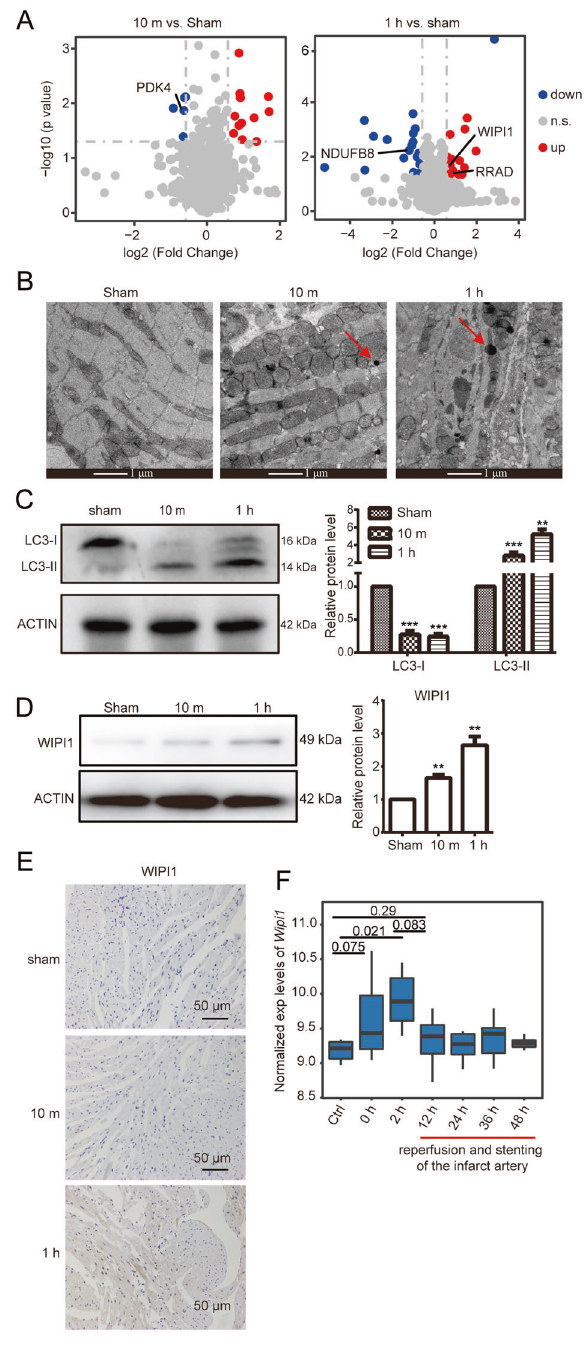
Fig. 5 WIPI1 serves as a potential early biomarker for AMI. A Volcano plots show the differentially expressed proteins (DEPs) in the 10-min (left) and 1-h (right) AMI samples compared to the sham samples. Red dots: the upregulated proteins; Blue: the down- regulated proteins; Gray: the not signi fi cantly changed proteins. B Electronic microscopic results show the morphologic changes in the 10-min and 1-h AMI samples compared to the sham samples. Arrows indicate autophagosomes (Bar = 1 μ m). C Signi fi cantly increased expression levels of the autophagosome-marker gene LC3-II at the early stages of AMI. Left: Western blotting analysis of LC3-I and LC3-II in the 10-min and 1-h AMI samples. Right: quanti fi cation of the Western blotting signals of LC3-I and LC3-II ( n = 3, ** P < 0.01, *** P < 0.001, Student ’ s t test). D Left: Western blotting analysis of WIPI1 in the 10-min and 1-h AMI samples. Right: quanti fi cation of the Western blotting signals of WIPI1 ( n = 3, ** P < 0.01, Student ’ s t test). E Masson staining results show WIPI1 was signi fi cantly expressed in the tissue of the 1-h AMI samples. F Boxplot shows the expression levels of WIPI1 in peripheral blood from patients with AMI. Ctrl healthy person (Student ’ s t